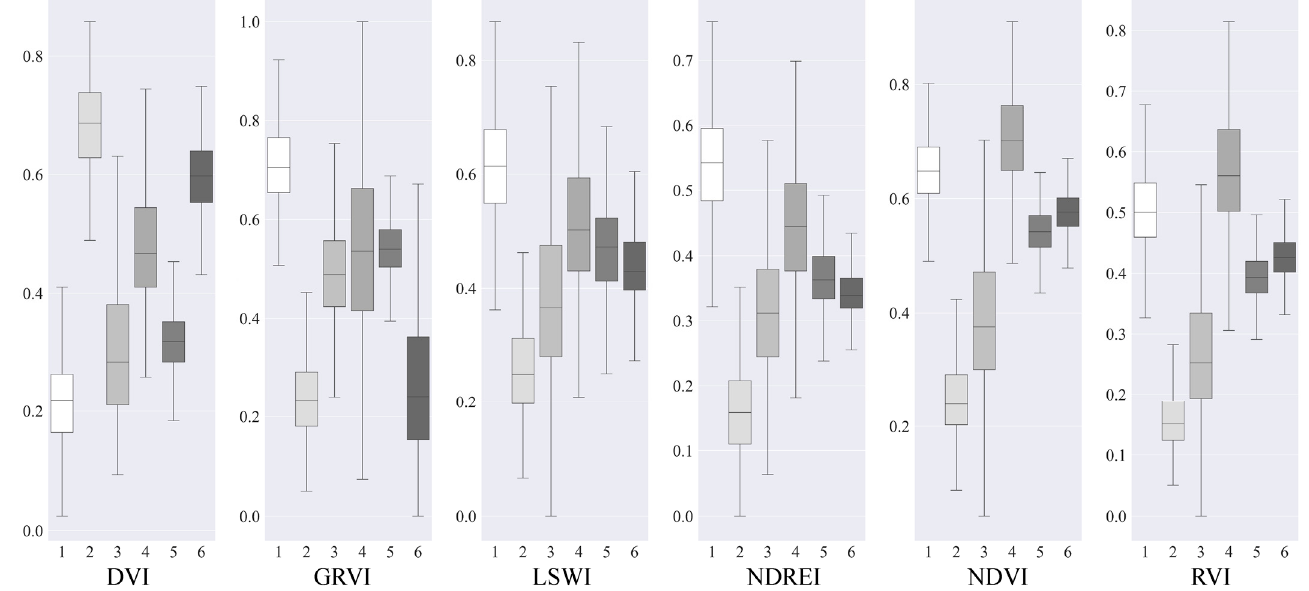
Figure 8. Boxplot of each category on the vegetation index. The centerline in each box in the boxplot is the median, and the edges of the box represent the upper and lower quartiles. Abscissa label: 1. Coniferous forests; 2. Impervious surface; 3. Barren land; 4. Shrubland; 5. Broad-leaved forests; 6. Grasslands.